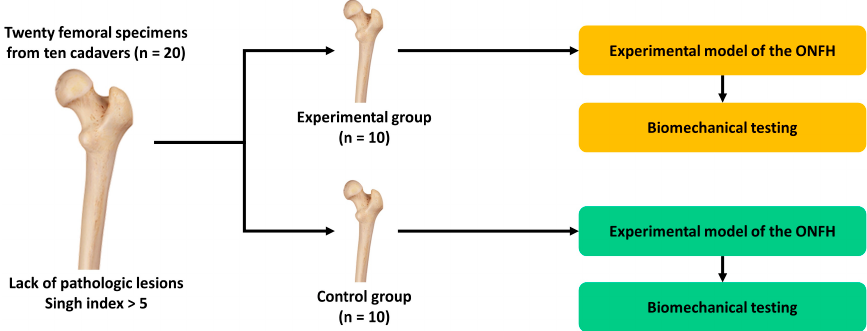
Figure 1. Experimental schema. Abbreviation: ONFH, osteonecrosis of femoral head.